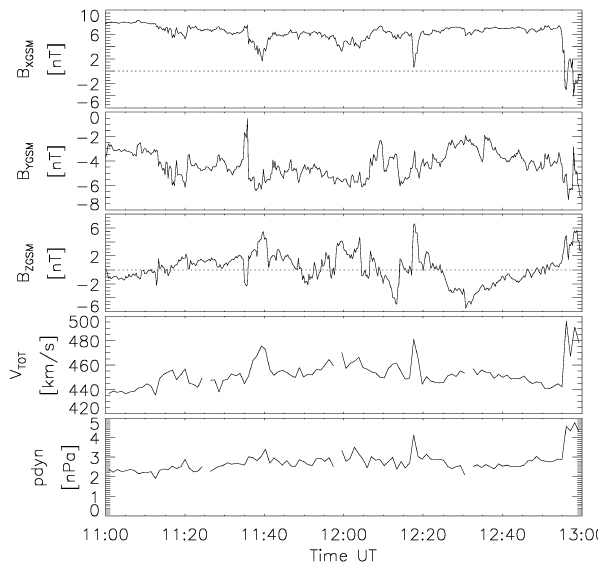
Fig. 1. Locations of the CARISMA magnetometers and the foot- print of s/c 1 in geomagnetic coordinates on 24 October 2004. The grey areas give the FOVs of the Saskatoon (looking East) and Ka- puskasing (looking North) SuperDARN radar.